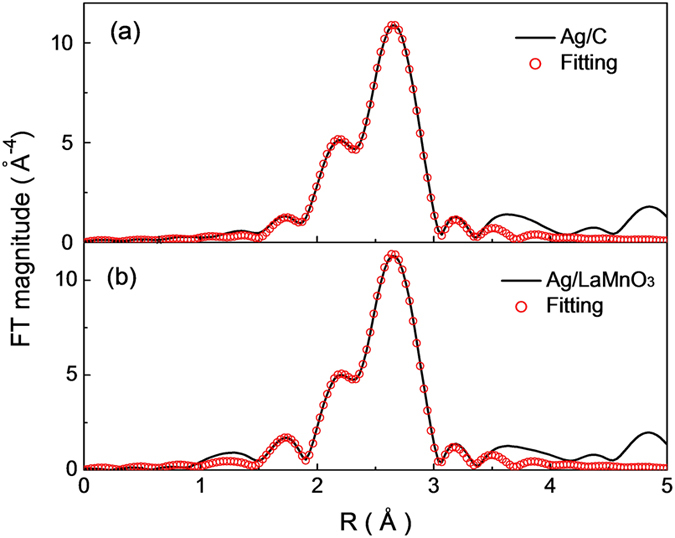
Fourier transforms of EXAFS spectra at the Ag K-edge of (a) Ag/C and (b) Ag/LaMnO3.